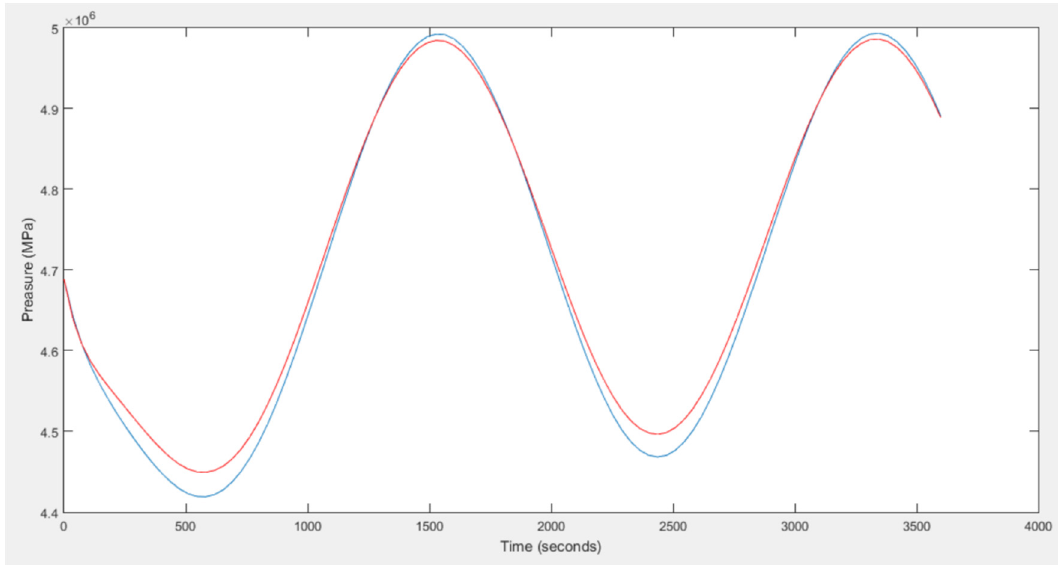
Figure 10. Length = 50 km, diameter = 0.7 m, mass flow = 120 kg/s .